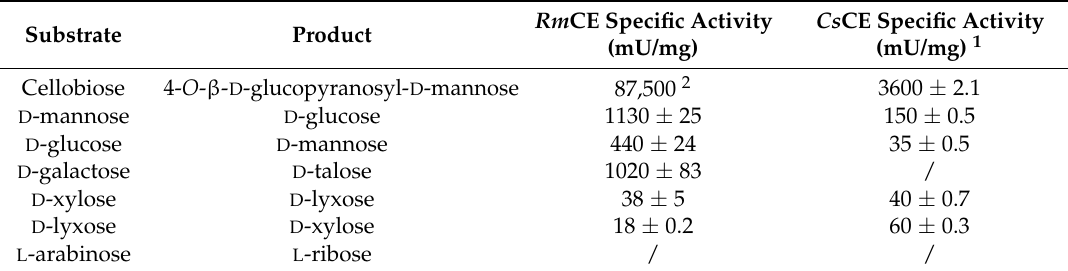
Table 1. Substrate specificity of Rhodothermus marinus ( Rm CE). Specific activities were determined on 200 mM substrate at pH 6.3 and 70 ◦ C. All tests were performed in triplicate and the standard deviation is reported for every substrate. No activity could be detected on L -arabinose.